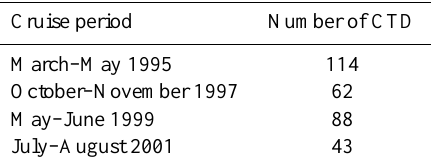
Table 1. REVIZEE cruises periods and the number of CTD profiles.